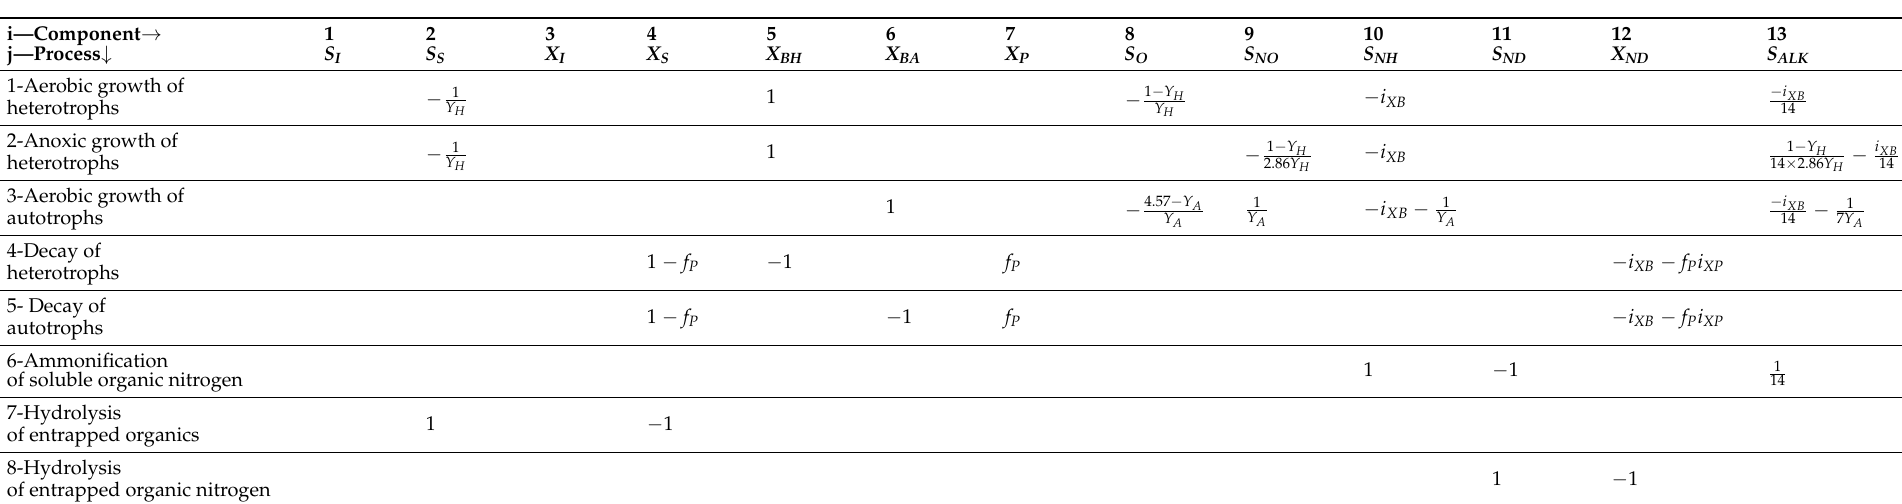
Table 1. Peterson matrix for the ASM1. Components are recorded in columns and processes can be identified in